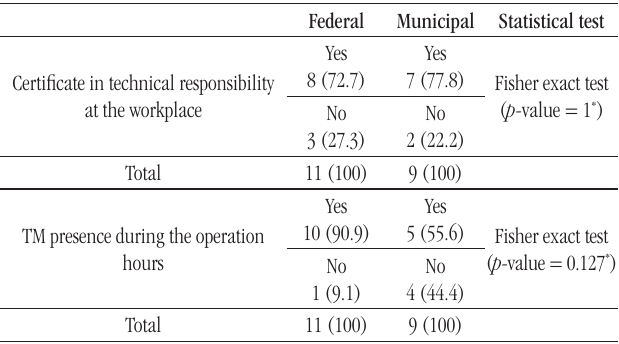
taBLE 1 − Number of certificates of technical responsibility and the presence of TM in municipal and federal CLA during CLA operating hours